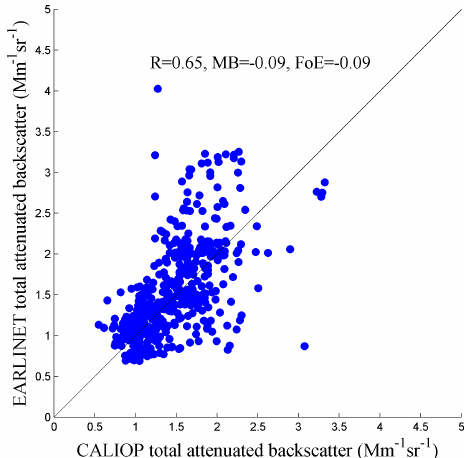
Figure 8. CALIOP vs EARLINET total attenuated backscatter for CALIOP overpasses over EARLINET stations for the PBL only, within 100km ground track distance.